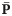
Average absolute (A-B) and relative (C-D) arm power (P¯arm) and leg and trunk (P¯T+L) power over the locomotion cycle in uphill DP at increasing external power at shallow (INC5, 5%) and steep (INC12, 12%) inclines. Values are mean and 95% CI [N = 14]. # indicates test for interaction; if sig. interaction, p-values are shown for simple main effect for each incline (5% and 12%) while if non-sig. interaction, p-values are shown for main effect of incline (Inc.) and WR (work rate); a,b, and c indicates sig. difference from low, mod, and high work rates at each incline, respectively (p<0.05); * indicates sig. difference between inclines at the same work rate (p<0.05).